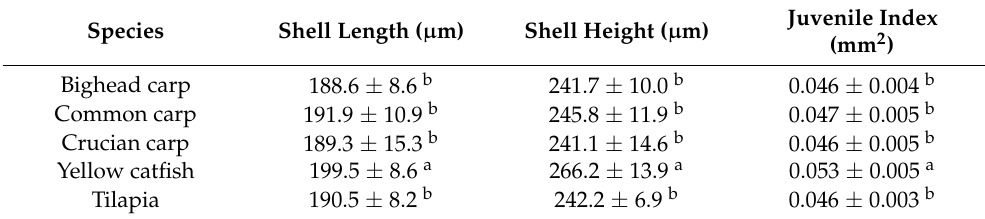
Table 3. Morphometry of freshly transformed juveniles from the five host species (mean ± SD; n = 30).